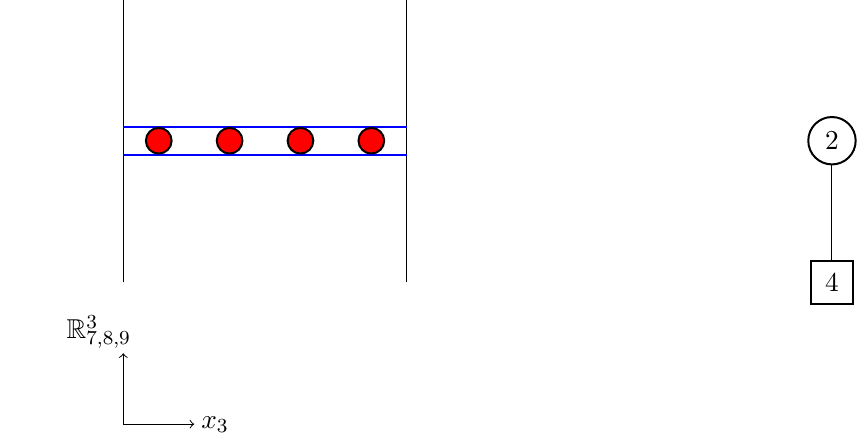
Figure 5 . The figure on the left shows the Type IIB brane construction for the linear quiver on the right. The red nodes represent D5 branes, the horizontal blue lines are D3 branes, and the vertical black lines represent NS5 branes.